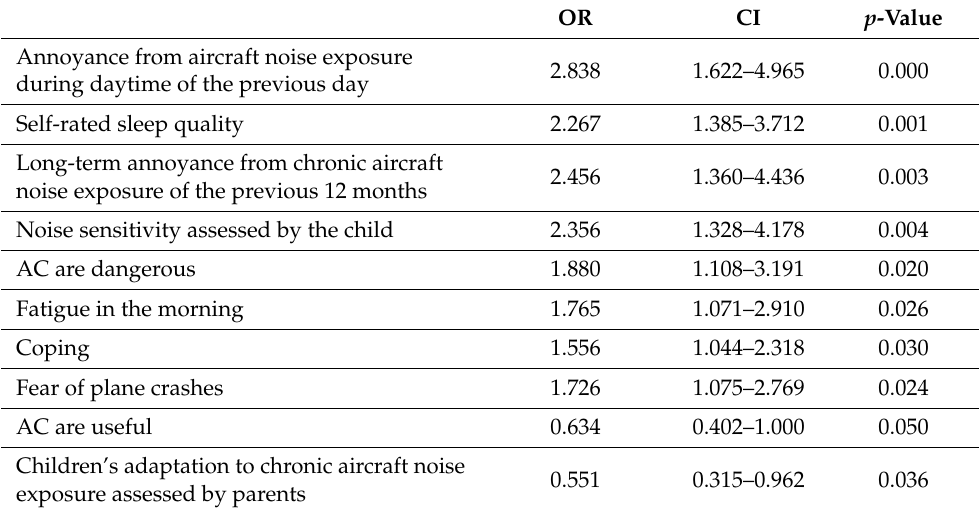
Table 2. Univariate logistic regression analyses with random effects of the non-acoustical predictors for aircraft noise-induced short-term annoyance at night in children. Odds Ratios (OR) with 95% Confidence Intervals (CI) and p -values. Illustrated predictor variables were measured using five- point scales.